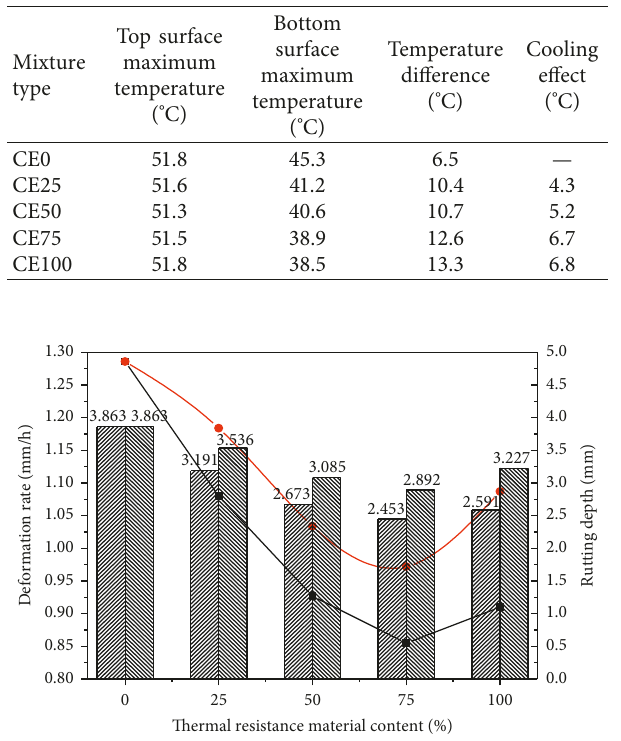
Figure 7: Temperature variation of the outdoor illumination test ( ° C). Table 7: Results of outdoor cooling effect for